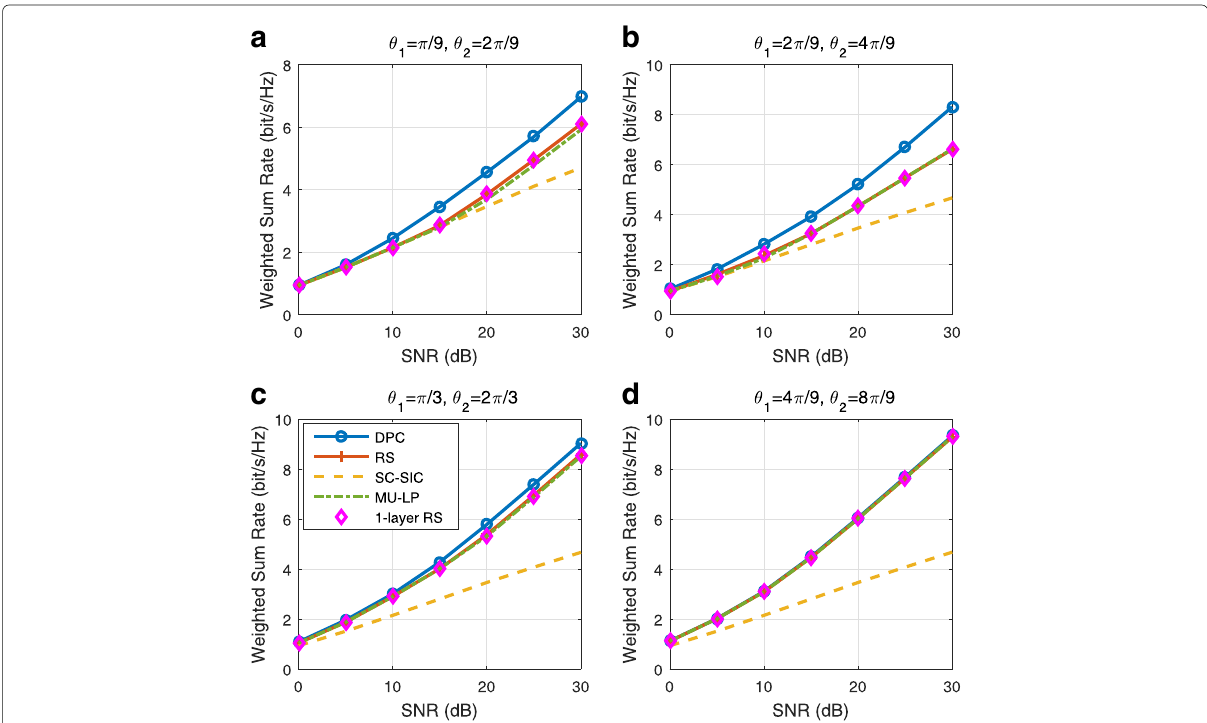
Fig.14 Weighted sum rate versus SNR comparison of different strategies for underloaded three-user deployment with perfect CSIT, γ 1 = 1, γ 2 =